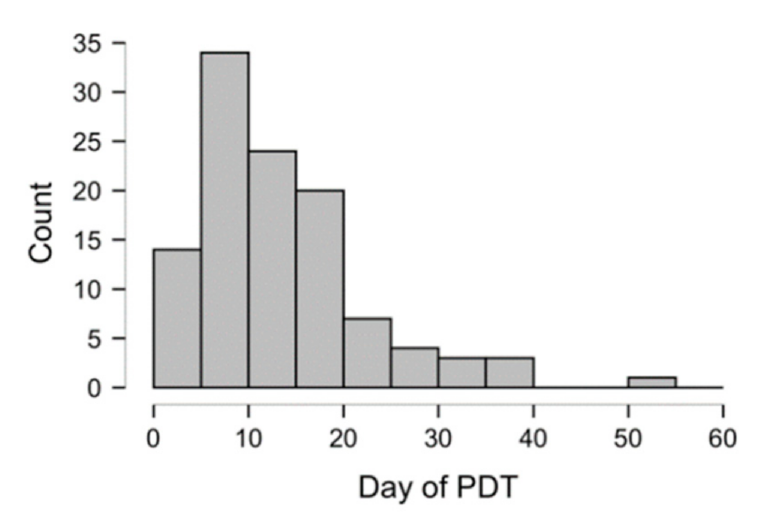
Figure 2. Frequency distribution of percutaneous dilatational tracheostomy (PDT) from orotracheal intubation (OTI).